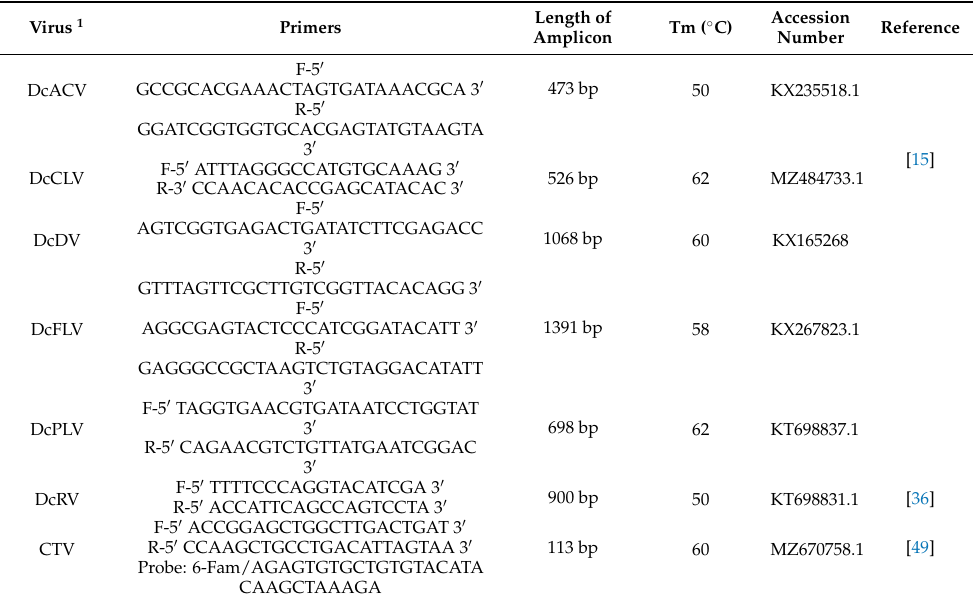
Table 1. List of detection primers and probes specific to D. citri -associated virus, and CTV used in the detection and quantification